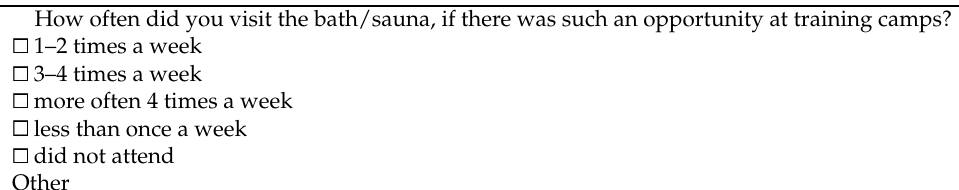
Table 5. The questionnaire “The use of sauna as a recovery method among highly. competitive athletes training endurance in the recovery of athletes”.